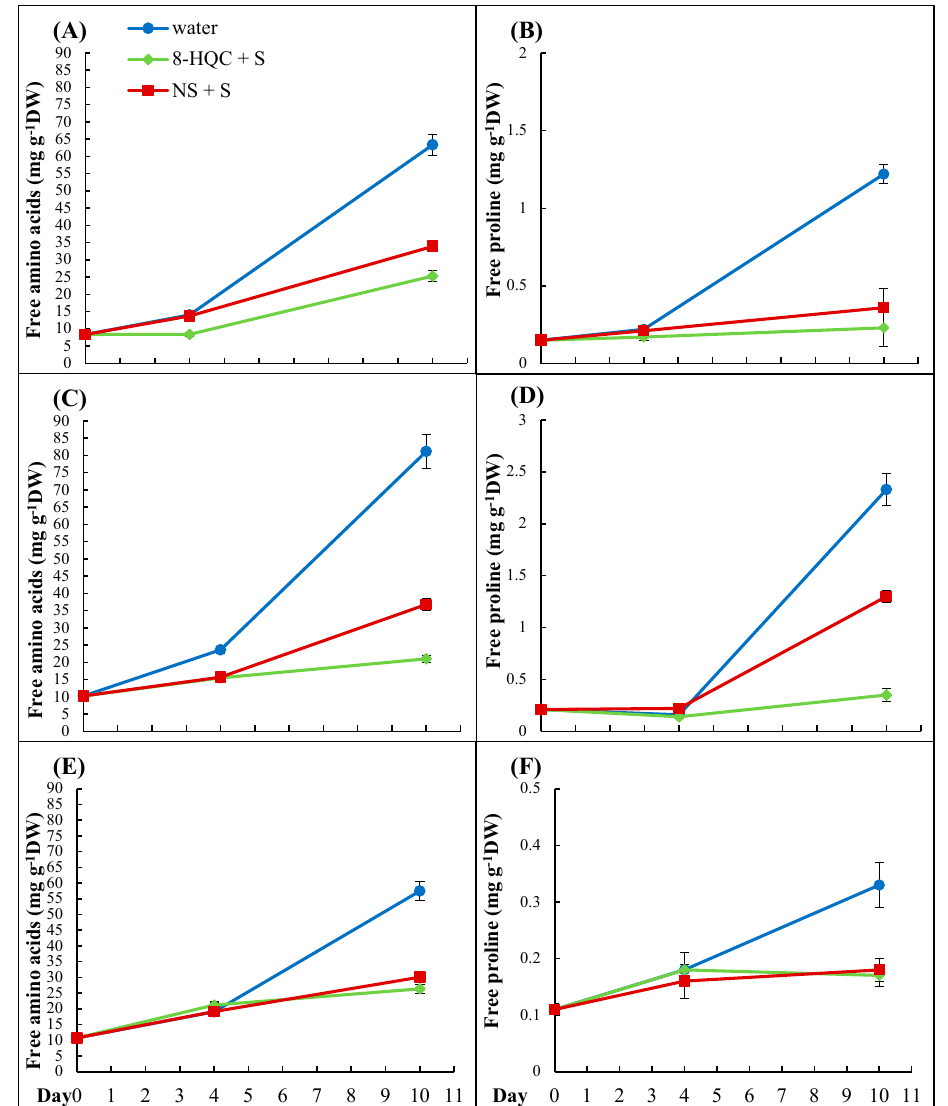
Figure 6. Free amino acid contents ( A , C , E ) and free proline contents ( B , D , F ) in cut flowers of peony ‘Charles Binder’ ( A , B ), ‘Festiva Maxima’ ( C , D ), and ‘Gayborder June’ ( E , F ). Values are expressed as the mean ± SD. Vertical bars represent standard deviations of the means.